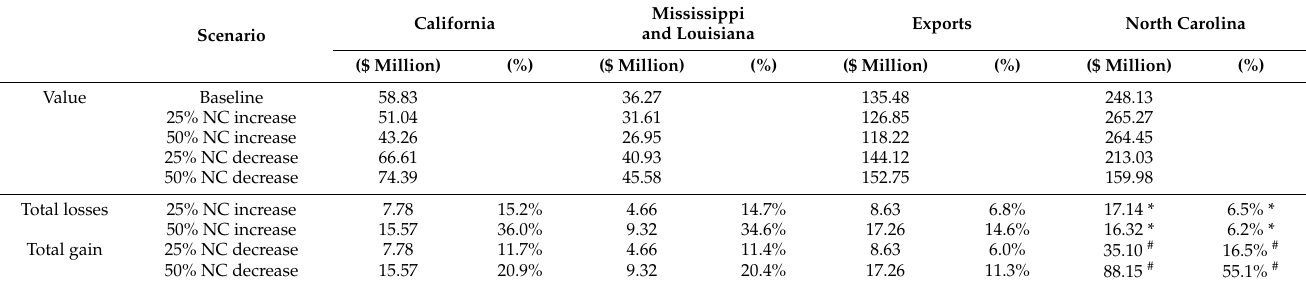
Table 5. Summary of changes in sweet potato shipment values under four